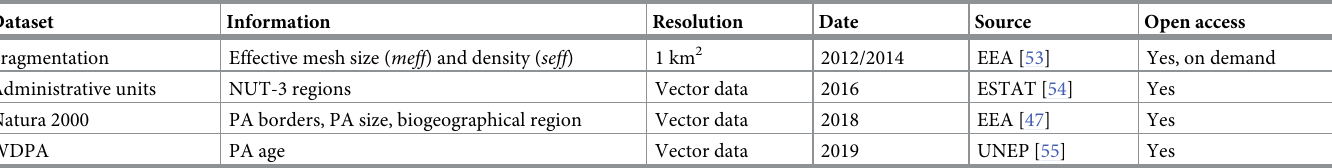
Table 2. Processed data. In this study, we used open-access data to derive information on fragmentation within and around Natura 2000 (N2k) PAs, N2k PA locations within one of nine biogeographical regions, their locations within specific administrative units, and PA age.